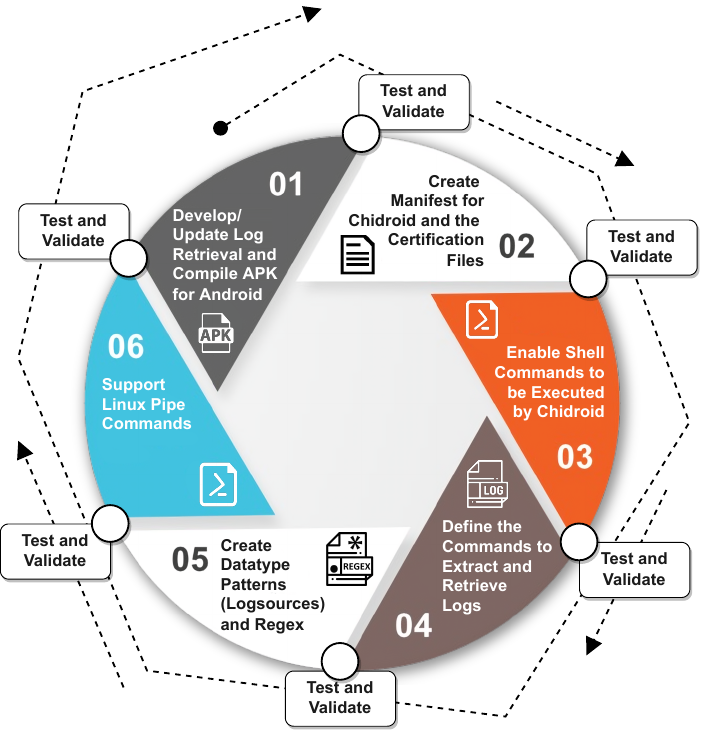
Figure 1. Methodology followed to develop, validate, and upgrade